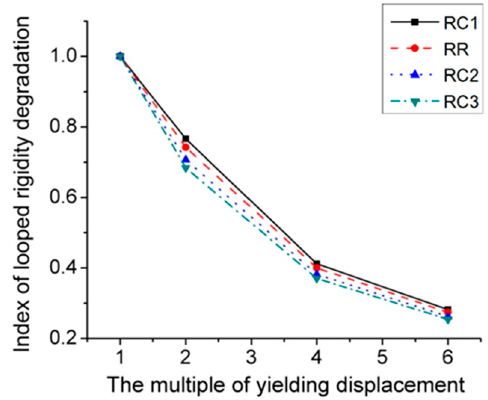
Figure 21. Index of looped rigidity degradation curves of RC series joints.